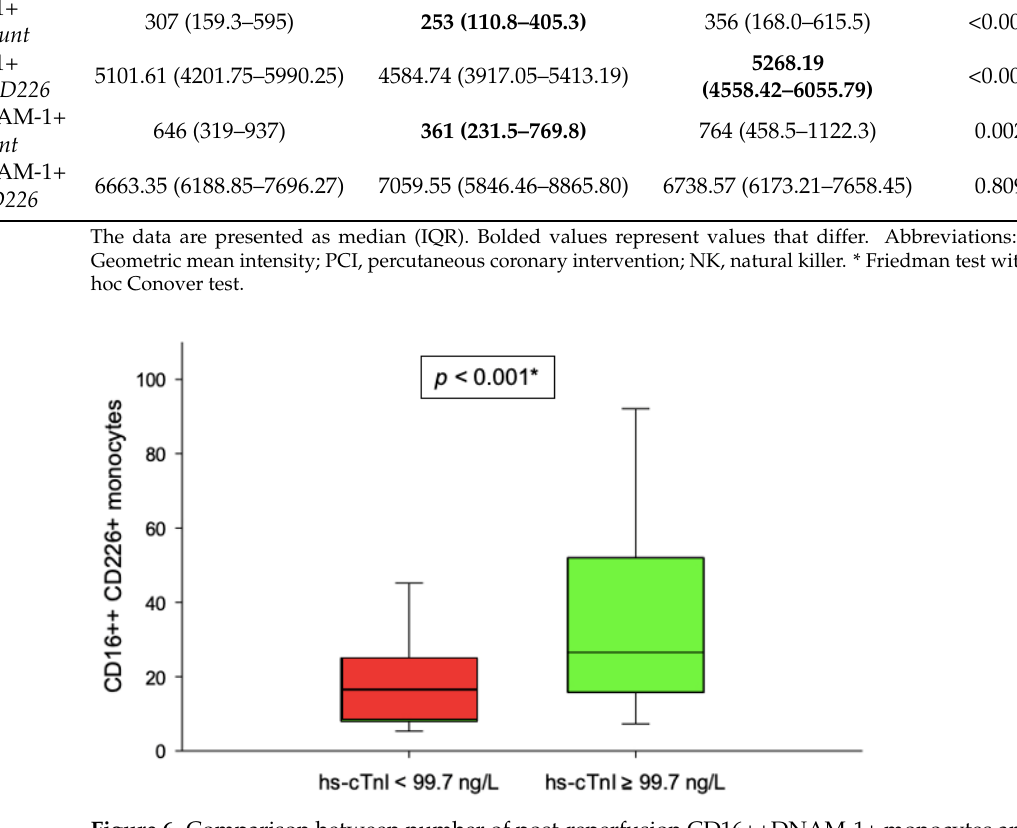
Figure 6. Comparison between number of post-reperfusion CD16++DNAM-1+ monocytes and the extent of myocardial injury. * Mann – Whitney U test.